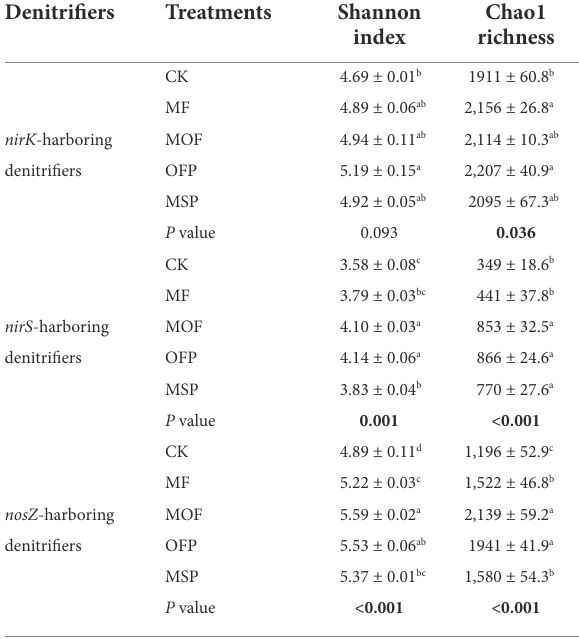
TABLE 2 The diversity indices of nirK -, nirS -, and nosZ -harboring denitrifies under different fertilization treatments.